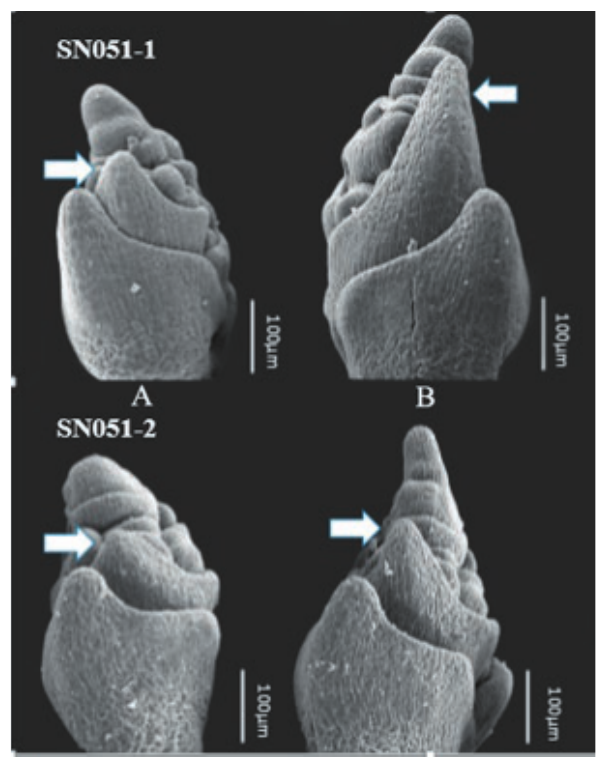
Figure 3. SEM images of SN051-1 and SN051-2 spikelets at differ- ent development stages. Arrows point to awn primordia; A pistil and stamen differentiation stage; B anther connective formation stage.